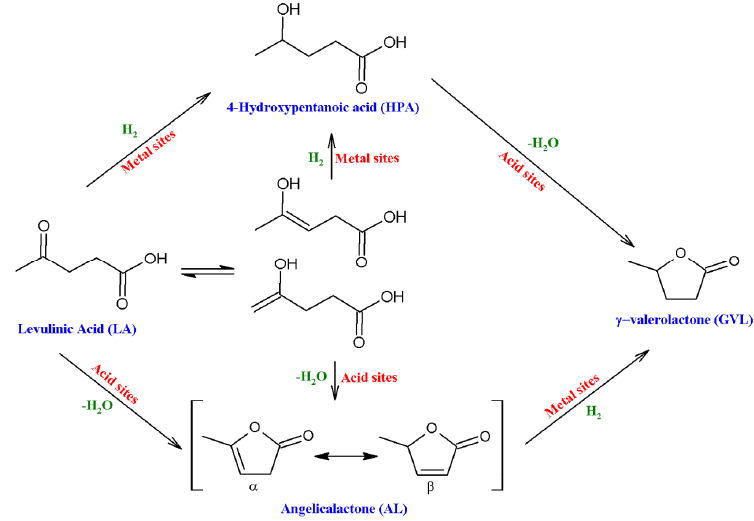
Table 4. Catalytic activity of Cu-based catalysts for hydrogenation of LA to